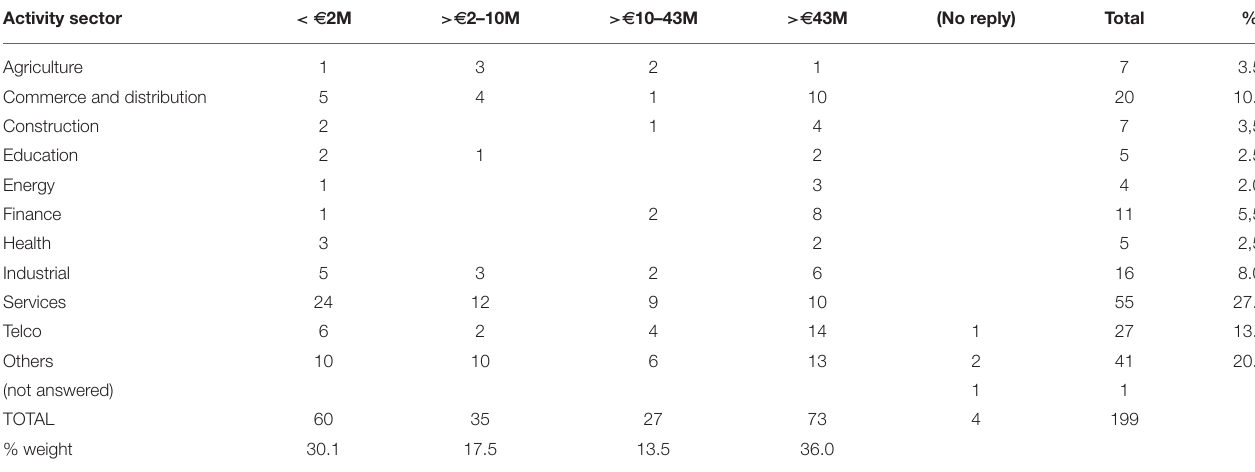
TABLE 2 | Participating companies by sales levels and activity